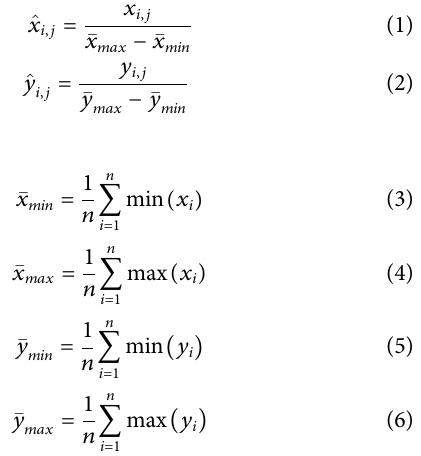
Frontiers in Bioengineering and Biotechnology |